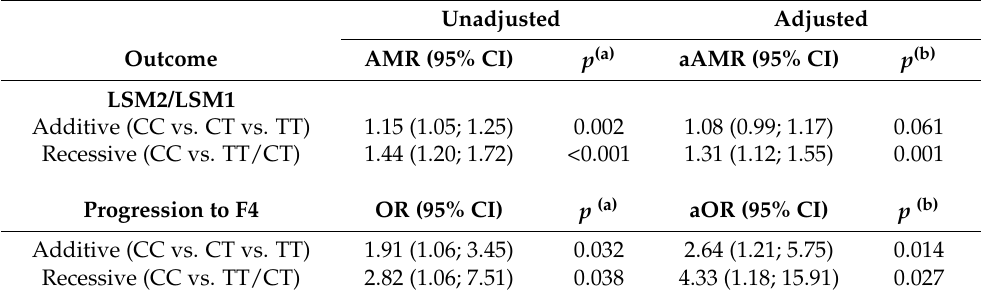
Table 3. Association between TRPM5 rs886277 polymorphism and liver fibrosis progression during the follow-up in HCV-infected